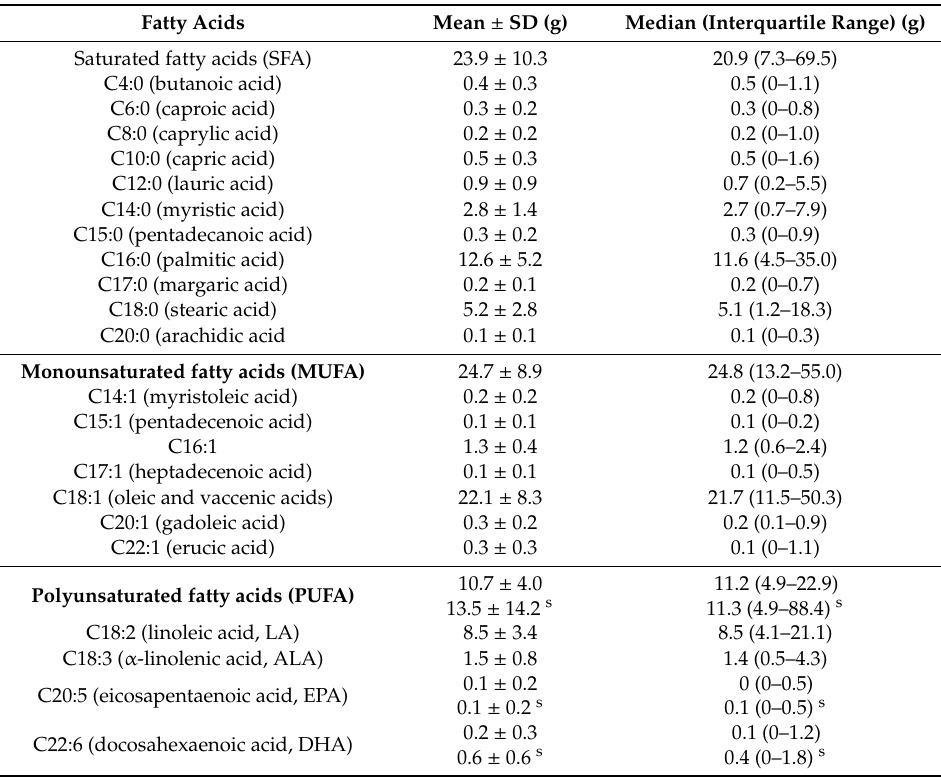
Table 3. Fatty acids content in mothers’ diet.